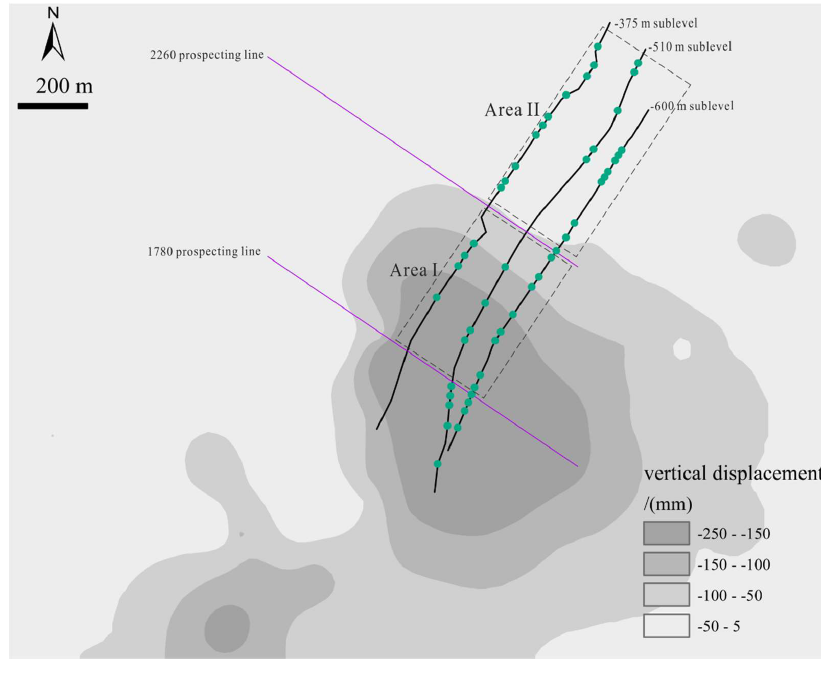
Figure 8. Vertical displacement caused by settlement in study area.